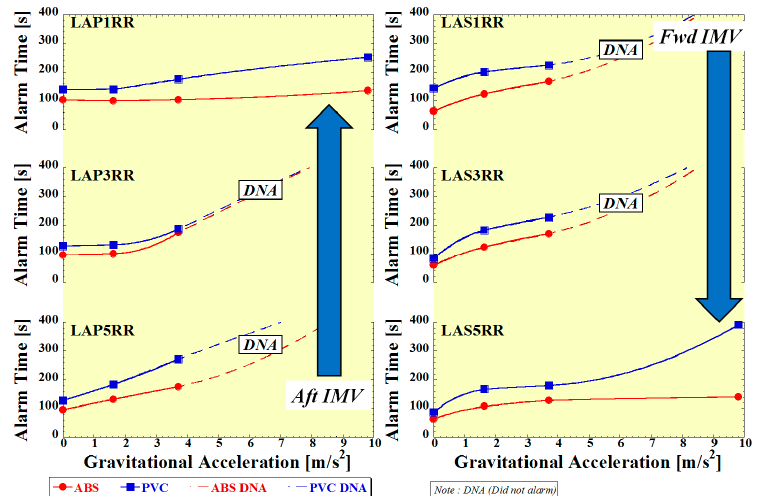
Figure 11. Detection time with respect to the gravity field environment of the smoke detector inside the Destiny module under IMV flow.